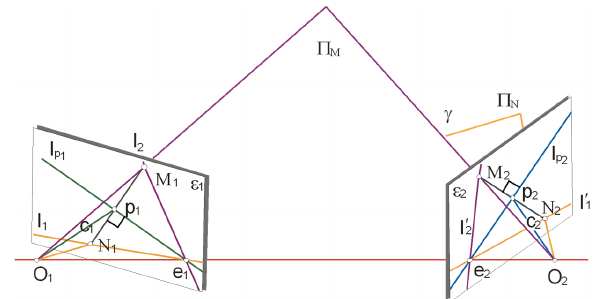
Figure 3. Epipolar planes Π Μ , Π Ν defined by two randomly selected epipolar lines l 1 , l 2 define a dihedral angle γ .